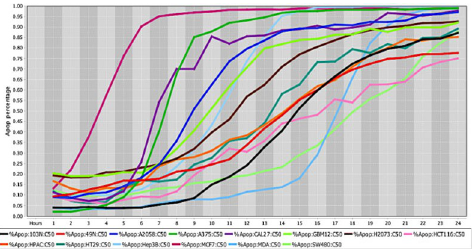
Fig 2. Cell death response curve for a variety of human cancers. Cell death response expressed in percentage of apoptosis in fourteen human cancer cell lines exposed to CT at 50 μ M concentration. Cancer cell lines are represented by colored lines: colorectal cancer (103N- black, 49N- red, HCT116- pink, HT29- dark green, SW480- light green), melanoma (A2058- royal blue, A375- green), squamous cell carcinoma (CAL27- purple), glioblastoma (GBM12- neon green), lung adenocarcinoma (H2073- brown), pancreatic adenocarcinoma (HPAC- orange), hepatocellular carcinoma (Hep3B- light blue), breast adenocarcinoma (MCF7- maroon), breast carcinoma (MDA-MB-453- sky